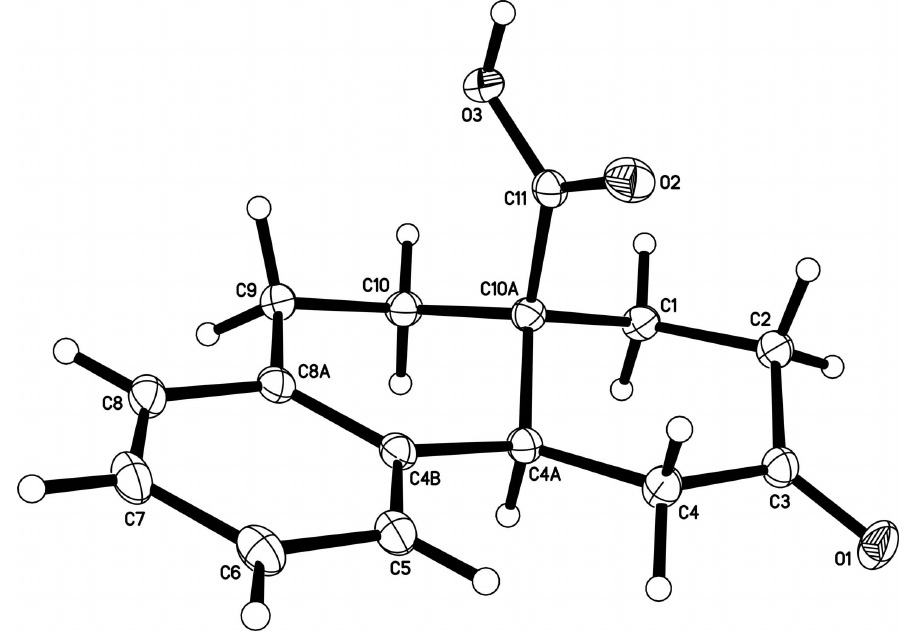
The asymmetric unit of (I), with its numbering. Displacement ellipsoids are drawn at the 30% probability